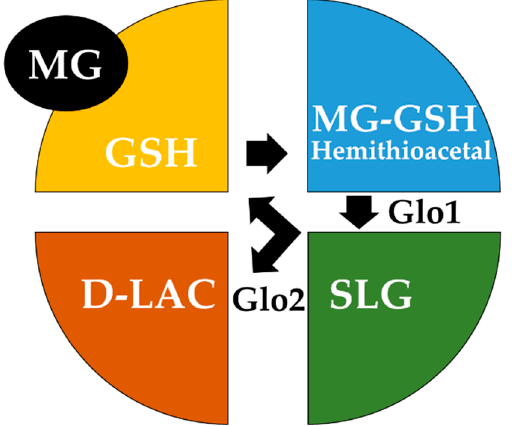
Figure 1. Schematic model of the glyoxalase system. The glyoxalase system consists of two glyoxalase enzymes, Glyoxalase 1 (Glo1) and Glyoxalase 2 (Glo2), and a catalytic amount of glutathione (GSH). Glo1 converts the hemithioacetal spontaneously formed between methylglyoxal (MG) and GSH to S-D-lactoylglutathione (SLG), whereas Glo2 catalyses the hydrolysis of SLG to D-lactate (D-LAC), regenerating GSH.